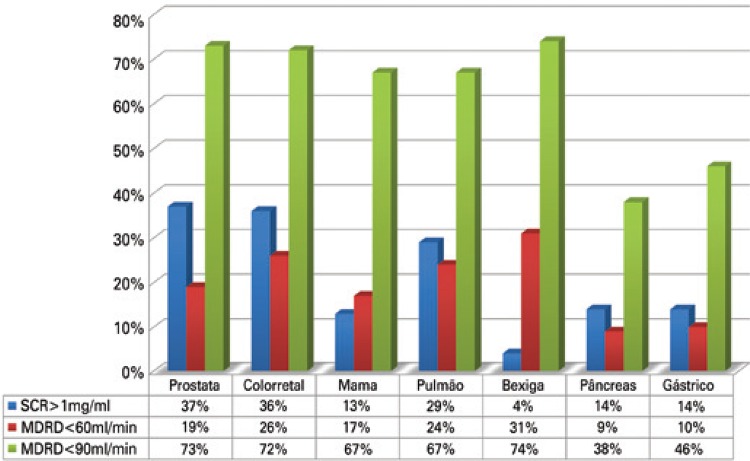
Doença renal crônica e os principais tipos de câncer